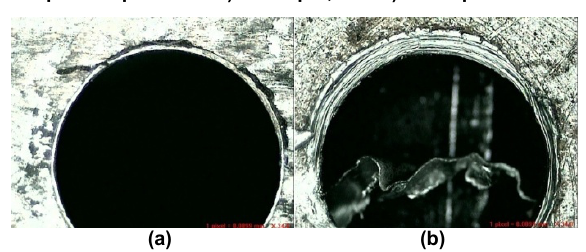
Figure 19. VMM images of holes “entrance” surface in CD at spindle speeds of: a) 1100 rpm, and b) 1700 rpm.